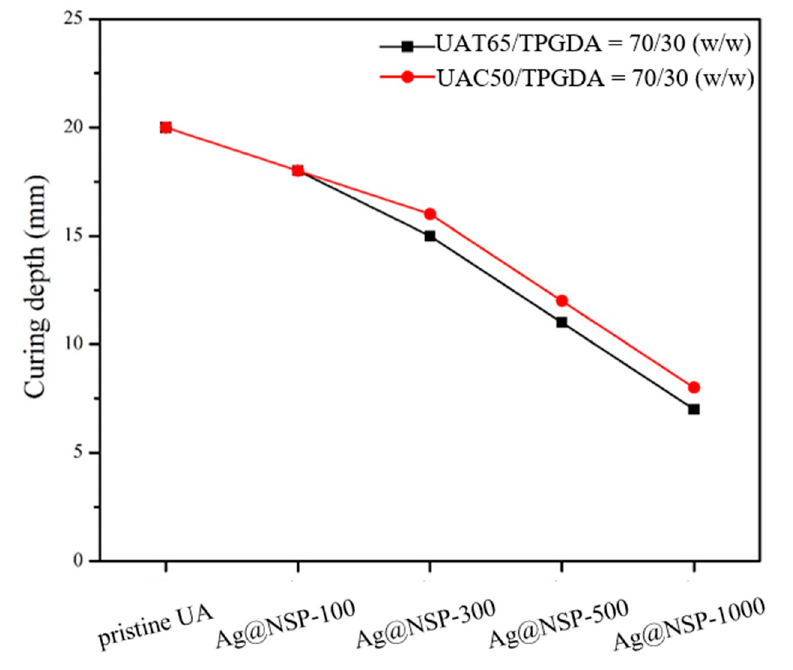
Figure 9. Curing depths of UAT65 / TPGDA resins ( w / w = 70 / 30) and UAC50 / TPGDA resins ( w / w = 70 / 30) with various Ag@NSP contents (ppm).